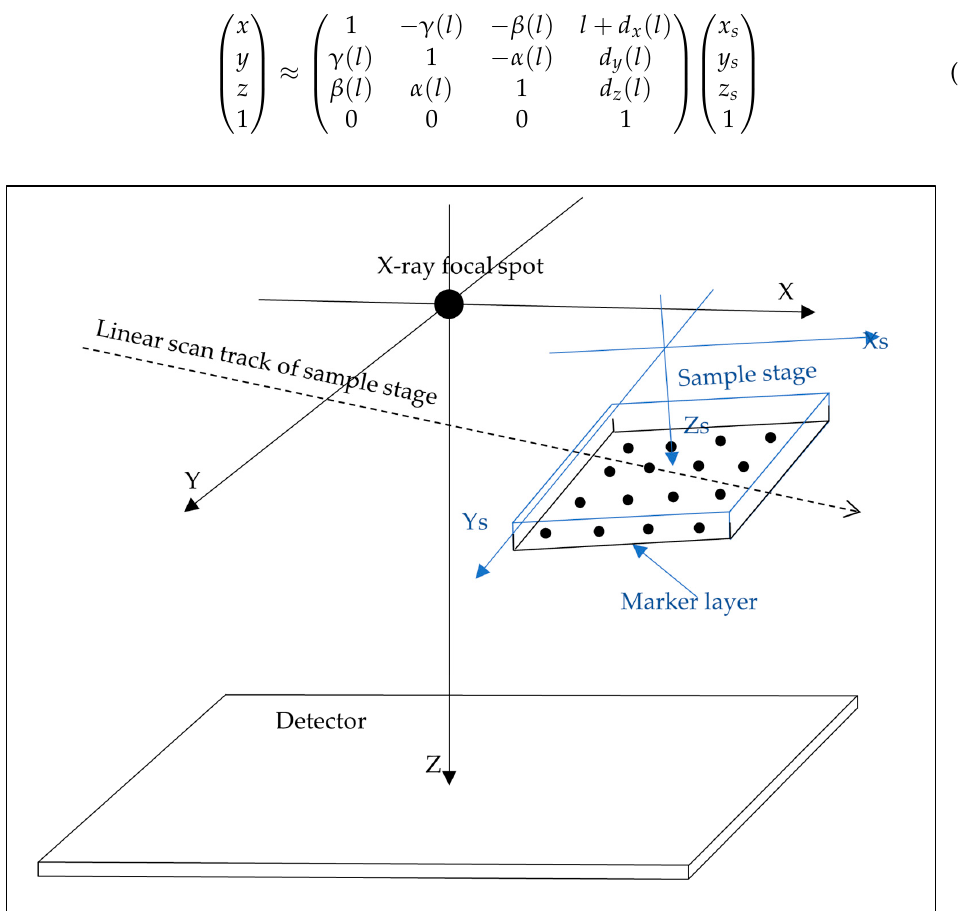
Figure 2. The definition of the sample coordinate system (X s , Y s , Z s ) and the stationary scanner coordinate system (X, Y, Z). The sample coordinate system is attached rigidly to the sample stage and moves with it during the scan. The two coordinate systems coincide with each other at the mid time point of the scan. The glass microbead layer serving as fiducial markers for online geometric calibration is rigidly attached to the sample stage, typically at 1 cm below the sample. The scan track may not be perfectly aligned with the X -axis and the sample stage may rotate slightly during the scan. An exaggerated version of such deviations is illustrated.